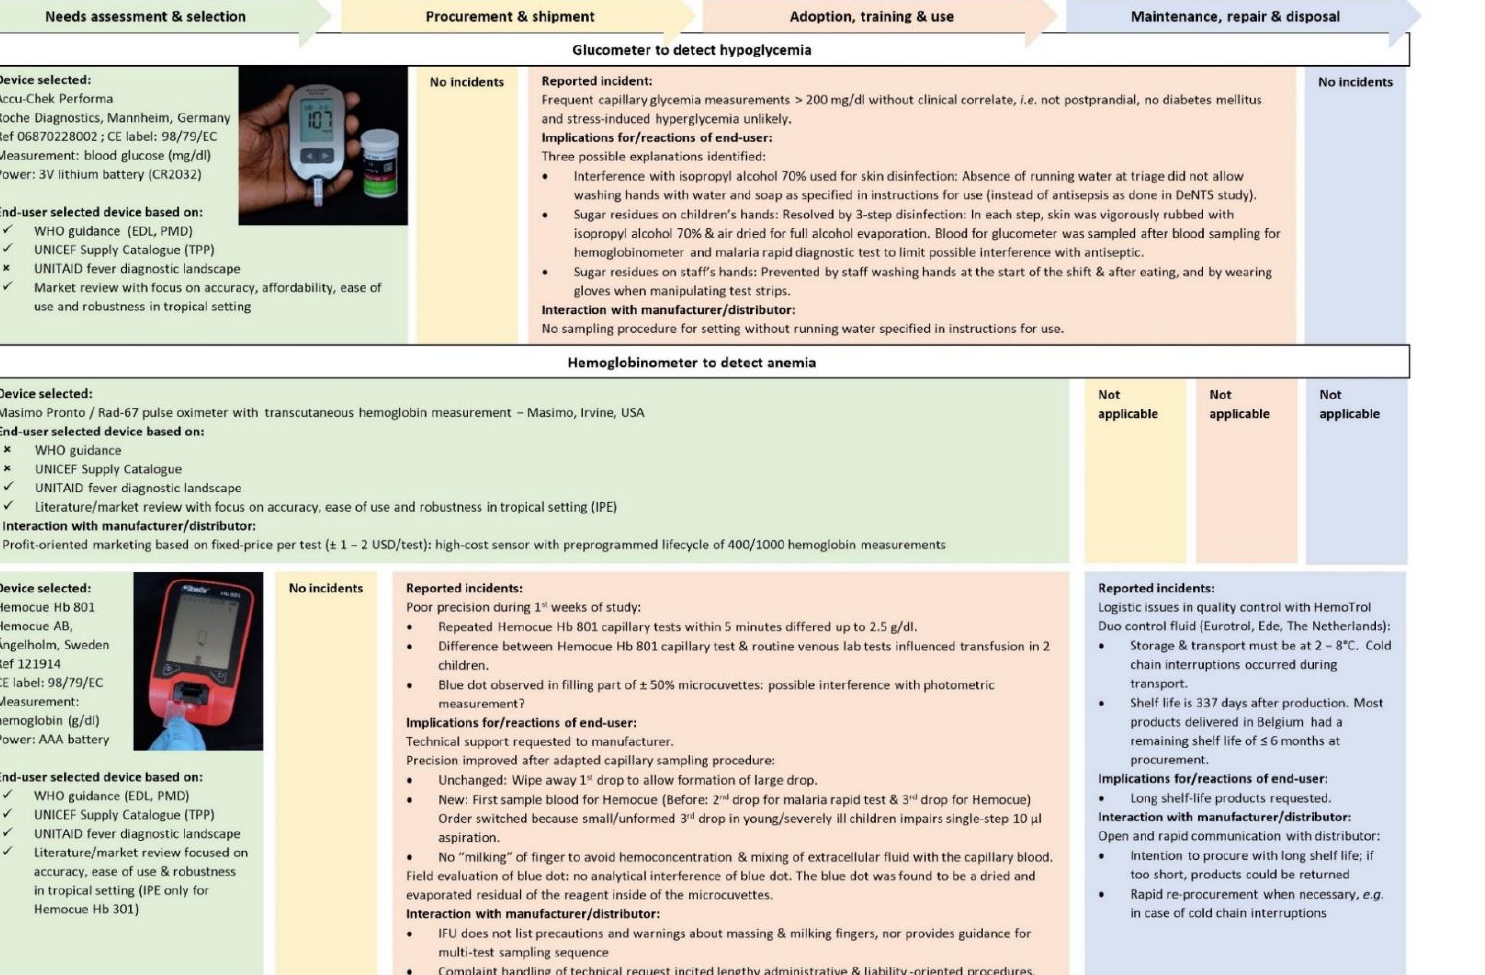
Figure 4. Field experiences reported by end-users during the lifecycle of handheld diagnostic devices to measure blood glucose & hemoglobin. Abbreviations & references: EDL: WHO Essential in vitro Diagnostics List [26], IPE: Independent Product Evaluations [51 – 54], TPP: Target Product Profile [55 – 57].